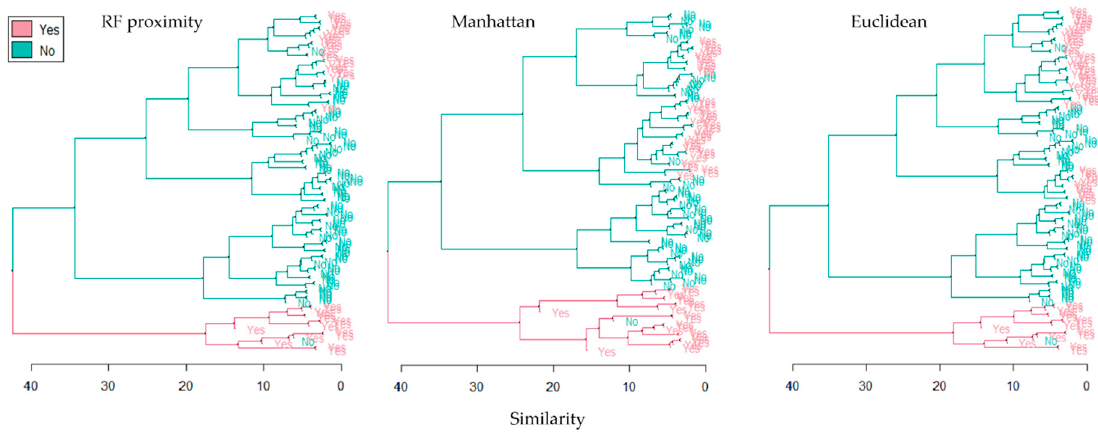
Figure 5. Hierarchical clustering of drought-affected (Yes) and non-affected (No) compartments using three similarity measures based on NDWI.